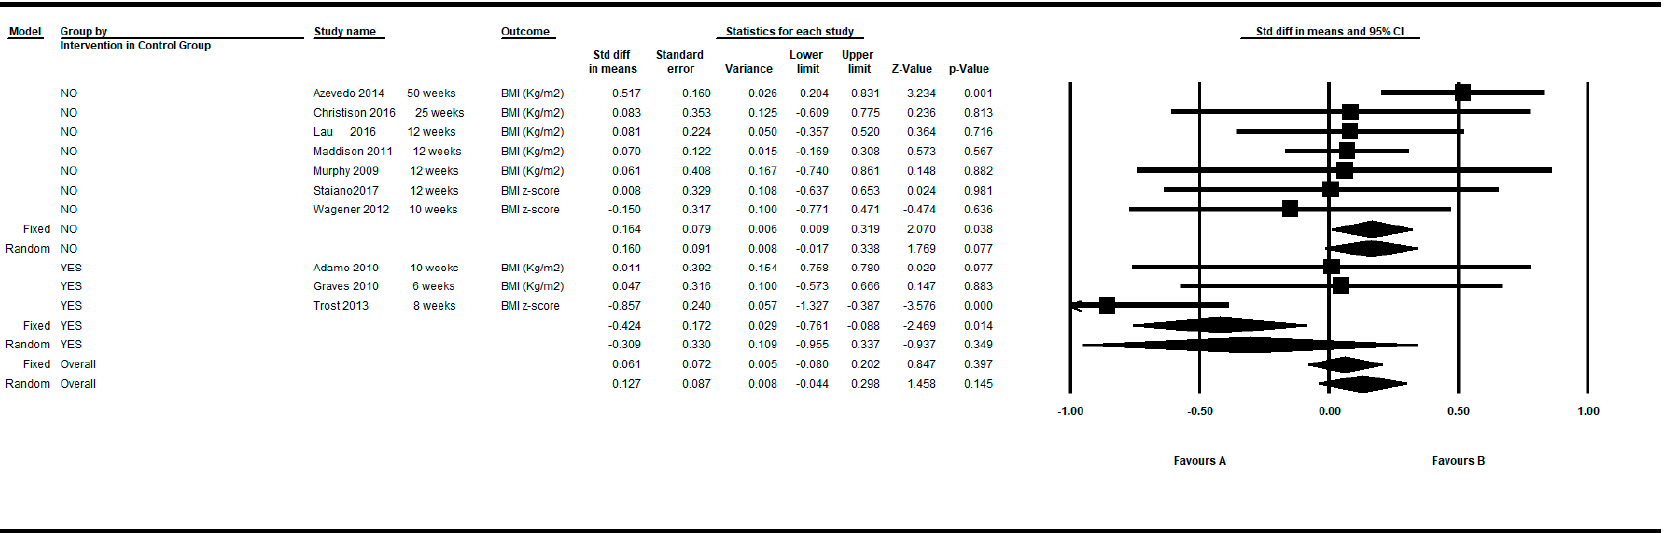
ff erence in BMI in the control group. All measurements in the shortest Figure 7. Pre-post intra-group difference in BMI in the control group. All measurements in the shortest follow-up. Figure 7. Pre-post intra-group di